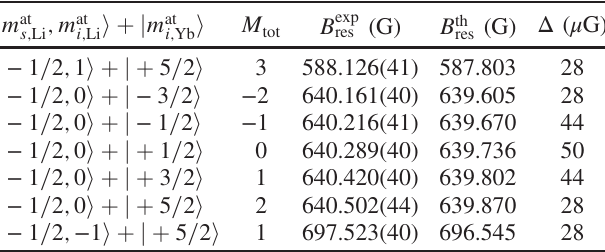
TABLE I. Observed 173 Yb 6 Li Feshbach resonance locations and corresponding theoretical predictions and assignments based on s -wave coupled-channels calculations. The first two columns describe the quantum numbers of the scattering states and the projection of the total angular momentum, respectively. The third column gives the observed resonance locations defined as the B field of maximum atom loss for a sample at our lowest temper- atures. Finally, the fourth and fifth columns give the resonance location and strength from the coupled-channels calculations. For all resonances the background scattering length is 30 . 4 a 0 and the magnetic moment difference between the molecular resonance and scattering channels is δμ ¼ 1 . 99 μ . The error in the observed B locations is the one-standard-deviation uncertainty from the quad- rature sum of the statistical error in the Gaussian fit and the systematic error in the field calibration. The theoretical locations of theresonanceshavea1.3Gone-standard-deviationuncertaintydue to the uncertainty of the binding energy of the most weakly bound state. The differences between neighboring resonances are not affected by this uncertainty. FIG. 4. (a) The observed (pink squares) and theoretically predicted (black circles) resonance locations near B ¼ 640 G as ; m functions of m . The 6 Li atom is in state j m i; Yb s; Li i; Li i ¼ j − 1 = 2 ; 0 i . For better visual comparison, the theoretical values have been uniformly shifted from those shown in Fig. 1(c). The shift is consistent with the 1.3 G uncertainty in the predicted resonance location. The dashed line is given by Eq. (7). (b) The 173 Yb 6 Li hyperfine coupling coefficient ζ R Þ (solid blue line) Yb ð and the radial wave function ϕ mol ð R Þ of the most weakly bound state of the 2 Σ þ potential (solid red line) as functions of separation R . Here, a 0 ¼ 0 . 05292 nm is the Bohr